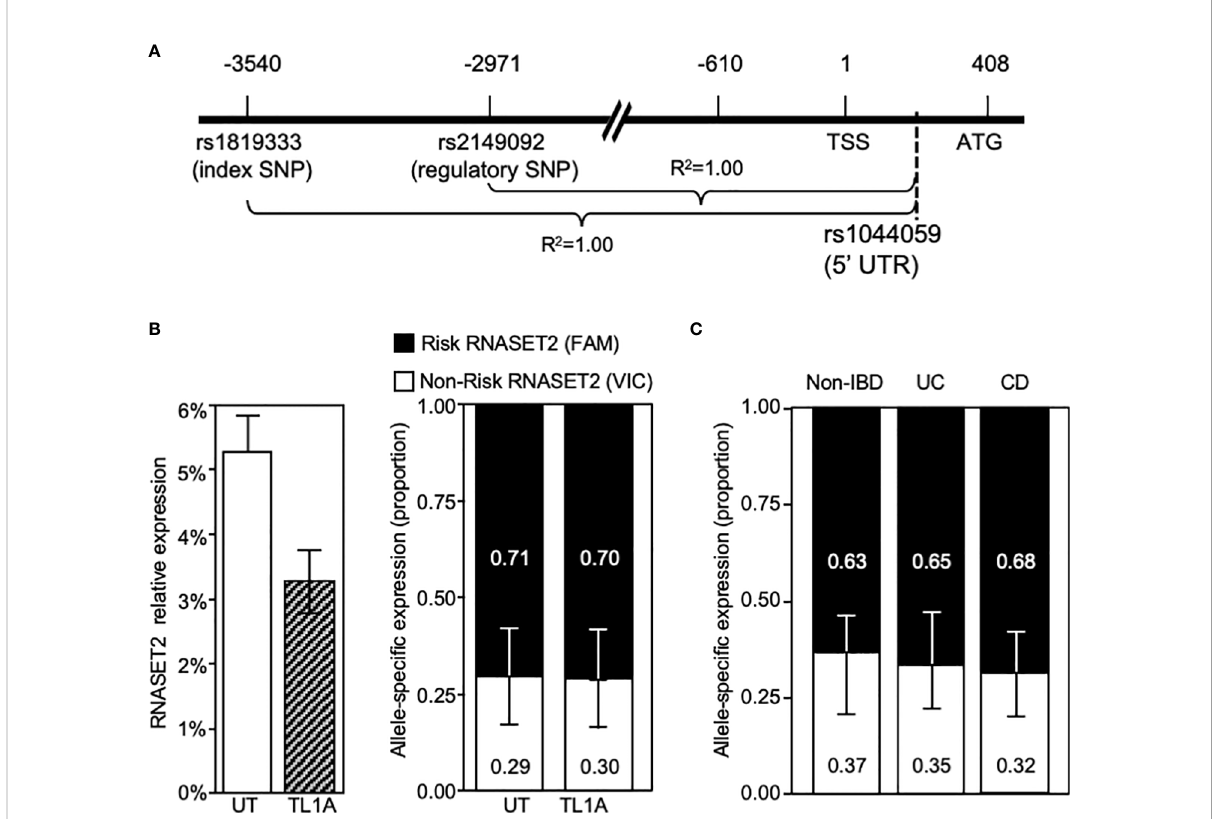
FIGURE 6 RNASET2 Risk variant dominates RNASET2 expression. (A) Diagram mapping the location and LD of rs1044059 on RNASET2 promoter. (B) Analysis in CD4 + T cells of total RNASET2 expression (left panel) or allele speci fi c expression (right panel) with or without TL1A activation of (n=12). Allele speci fi c expression in (C) . Resting PBMC isolated from non-IBD ( n =6), CD ( n =9) or UC ( n =8) subjects. Across all samples the allele speci fi c ratio of risk vs. non-risk expression was ~ 2:1 with a p value